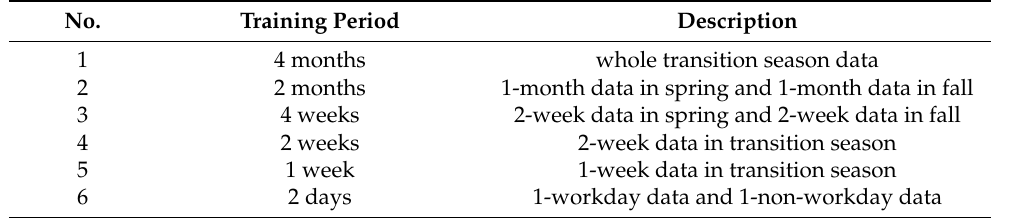
Table 4. Summary table of the training data size selection. No. Training Period